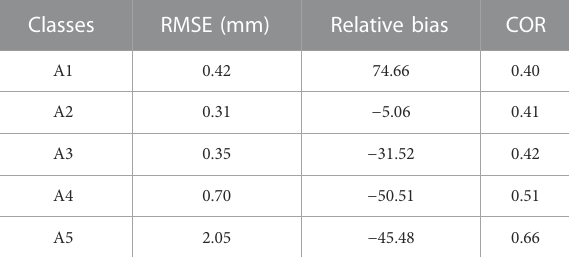
TABLE 5 Comparison of RMSE, relative bias, and COR among the fi ve rainfall rate classes (A1 – A5). Classes RMSE (mm)